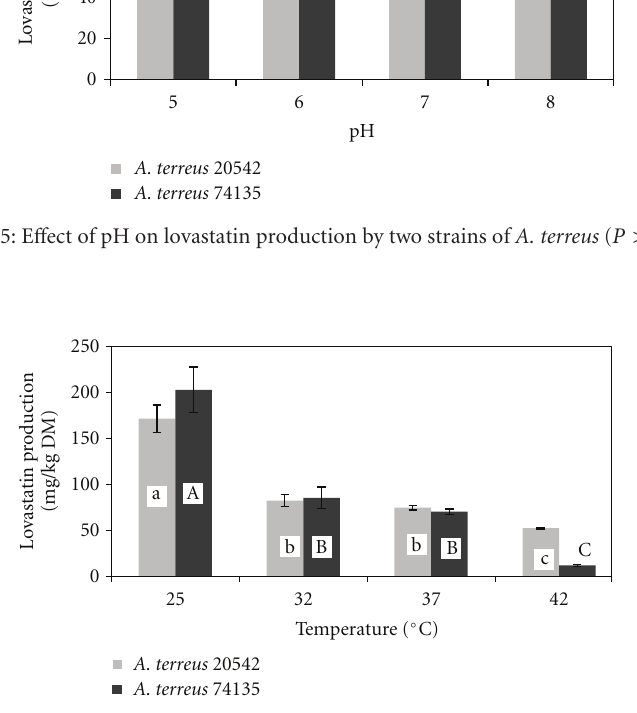
Figure 6: E ff ect of incubation temperature on lovastatin production by A. terreus ( P < 0 . 01). (a, b, and c) indicate di ff erences among means between samples for A. terreus ATCC 20542. (A, B, and C) indicate di ff erences among means between samples for A. terreus ATCC